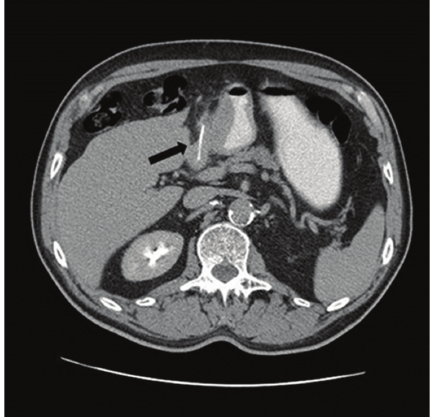
Figure 3: CT scan: submucosal heterogeneous enhancing mass in the distal stomach, that produced a stricture of the gastric lumen. Black arrow shows the presence of linear radiopaque foreign body.